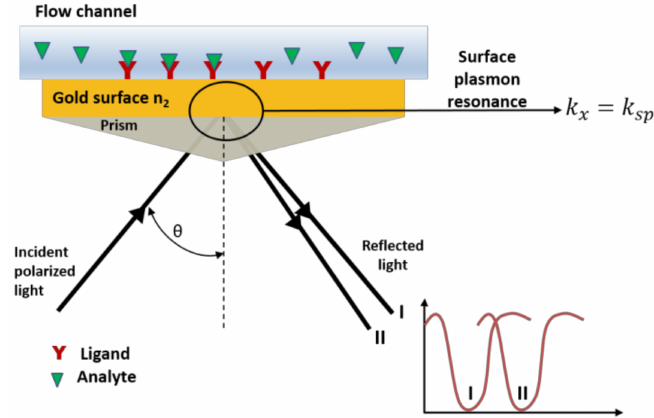
Figure 7. General principle of SPR, where n2 is the refractive index of medium with lower refractive index, E is the evanescent field amplitude, k sp is the wavevector of surface plasmons, and k x is the wavevector of